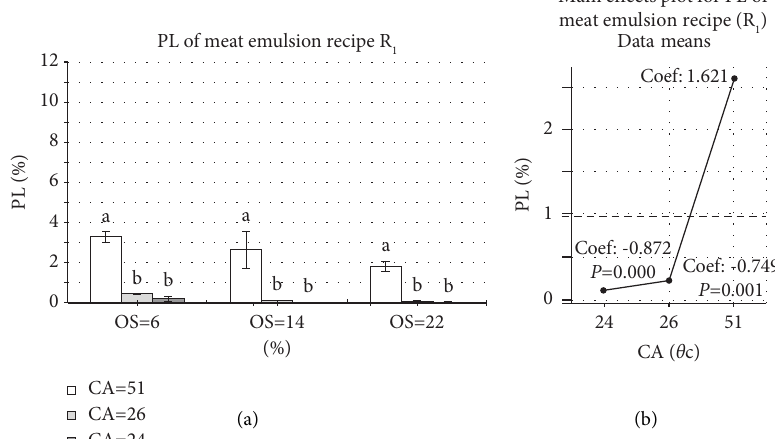
Figure 2: Mean ± SE of pH (a) and total expressible fuid (TEF) (b) of raw meat emulsions R (yellow) in each recipe are represented in column charts in secondary axis.